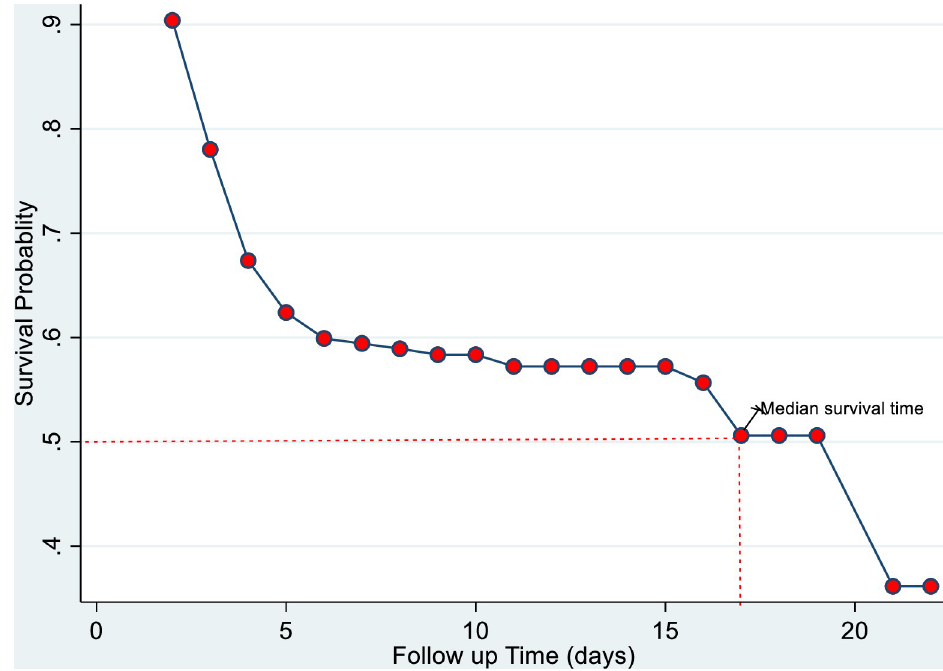
Fig 3. Overall Kaplan-Meier curve of newborns with asphyxia in Northwest Ethiopia selected hospitals from November 1, 2018, to November 1, 2019.